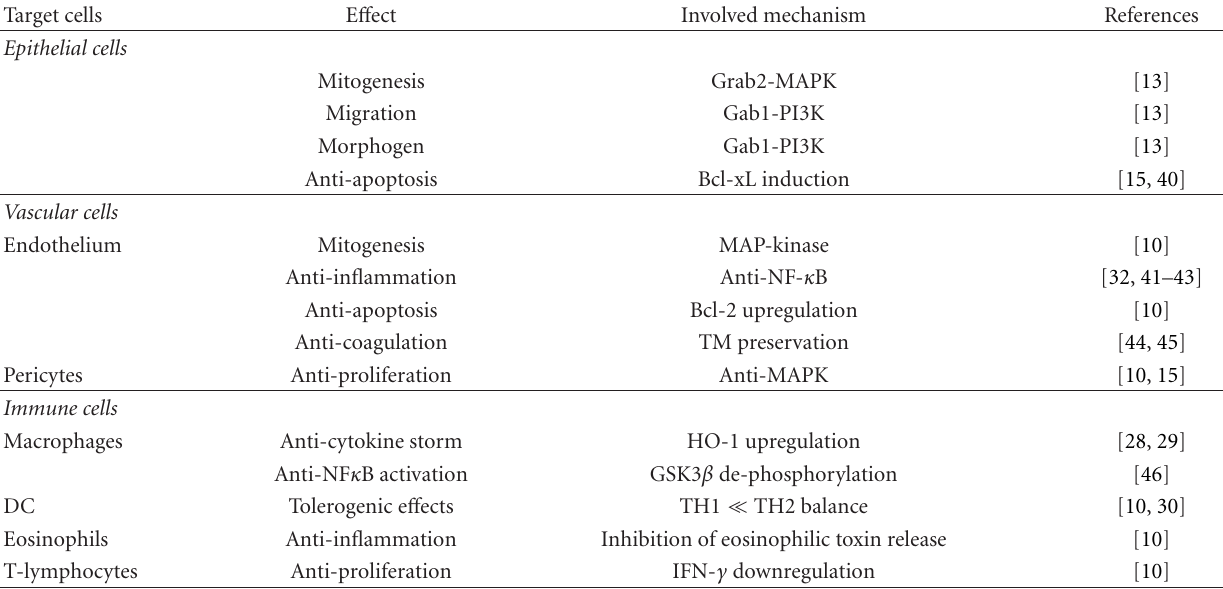
Table 1: Biological e ff ects of HGF on target cells, involved in sepsis-related